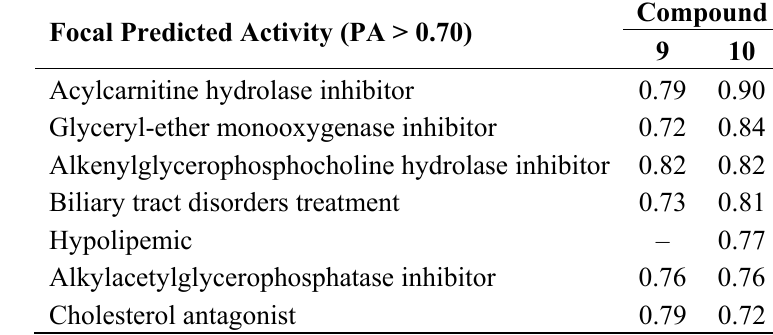
Table 1. Probability ‘to be Active’ (PA) values for the predicted biological activity of compounds 9 and 10 .